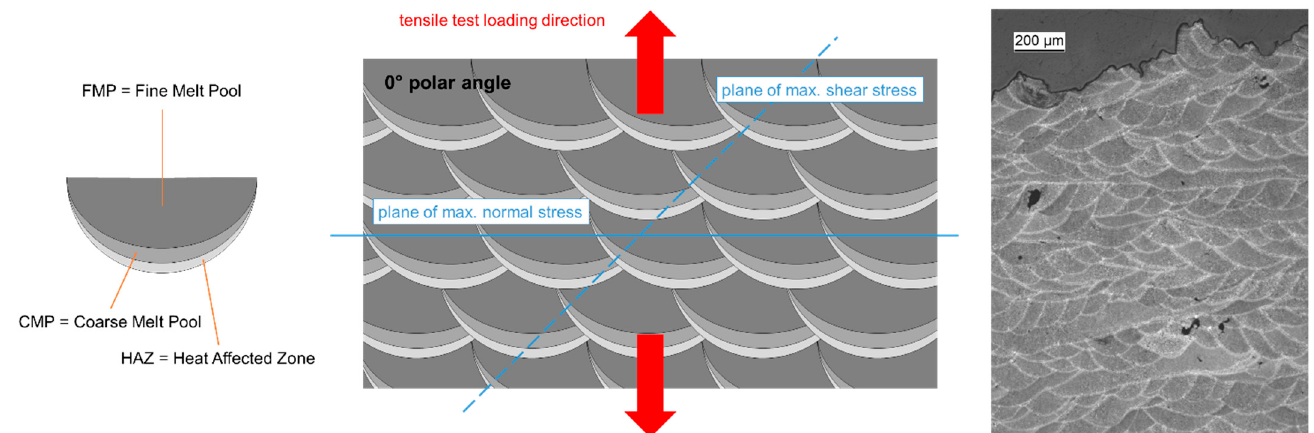
Figure 16. Microstructure of a sample printed at a 0° polar angle and cut in the xz plane assuming laser scanning in y -direction. The difference in comparison to the micrograph is due to the fact that for one thing the schematic representation does not account for the 60° layer-to-layer shift of the scanning direction, and besides the orientation of the micrograph is at an arbitrary angle to the scanning direction(s). The sketch to the left depicts the main microstructural zones based on the designation by Santos Macias et al. [43].